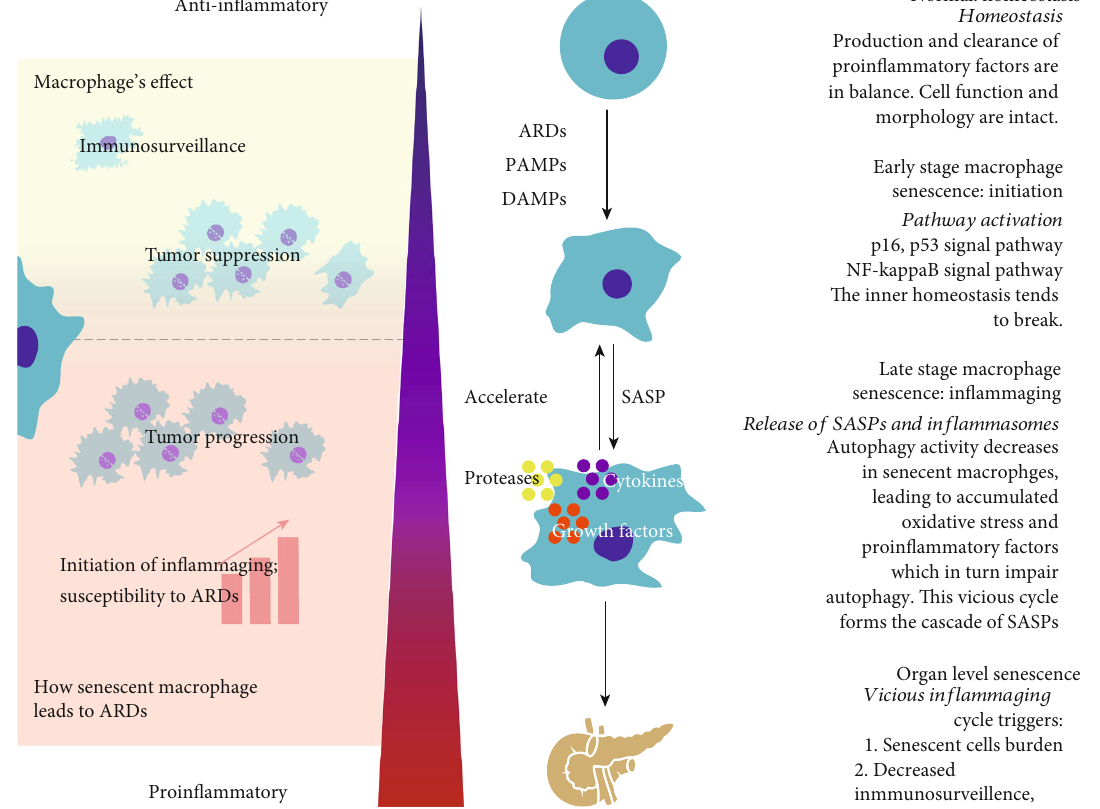
Figure 1: Schematic of the process of cellular senescence and its dual e ff